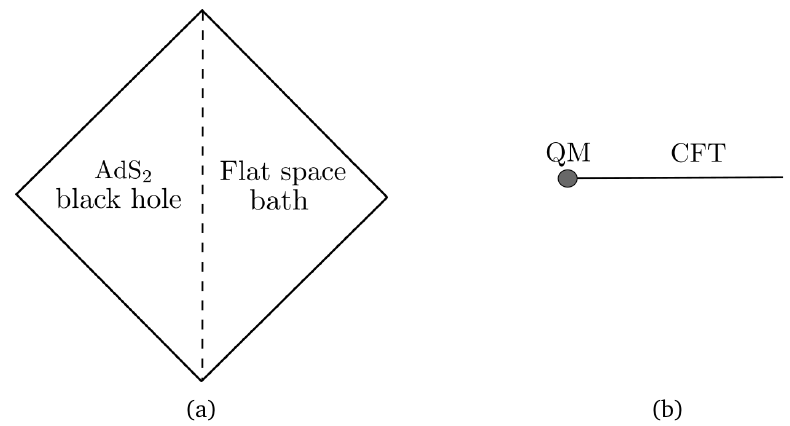
Figure 4: (a) An extremal AdS black hole coupled to a zero temperature flat space 2 bath, with conformal matter. (b) The holographic dual, a CFT on a half line with ‘black hole’ degrees of freedom at the